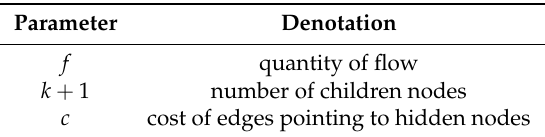
Table 3. Parameters tuning in the minimum-cost flow